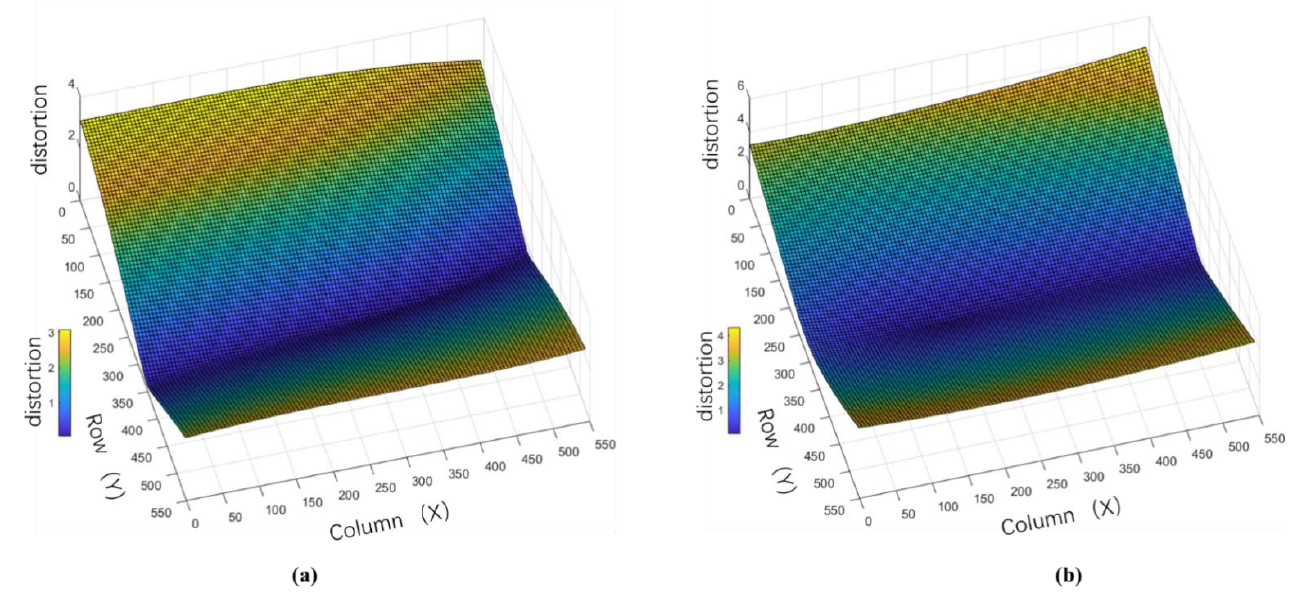
Figure 6. Internal distortion of laser footprint cameras (LFCs). ( a ) Internal distortion of LFC1. ( b ) Internal